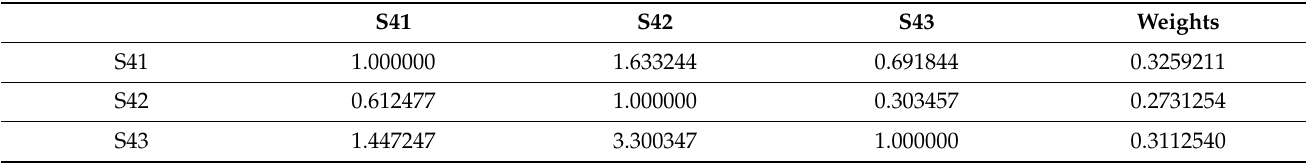
Table 10. The aggregated pairwise comparison matrix at Level 2 for design.